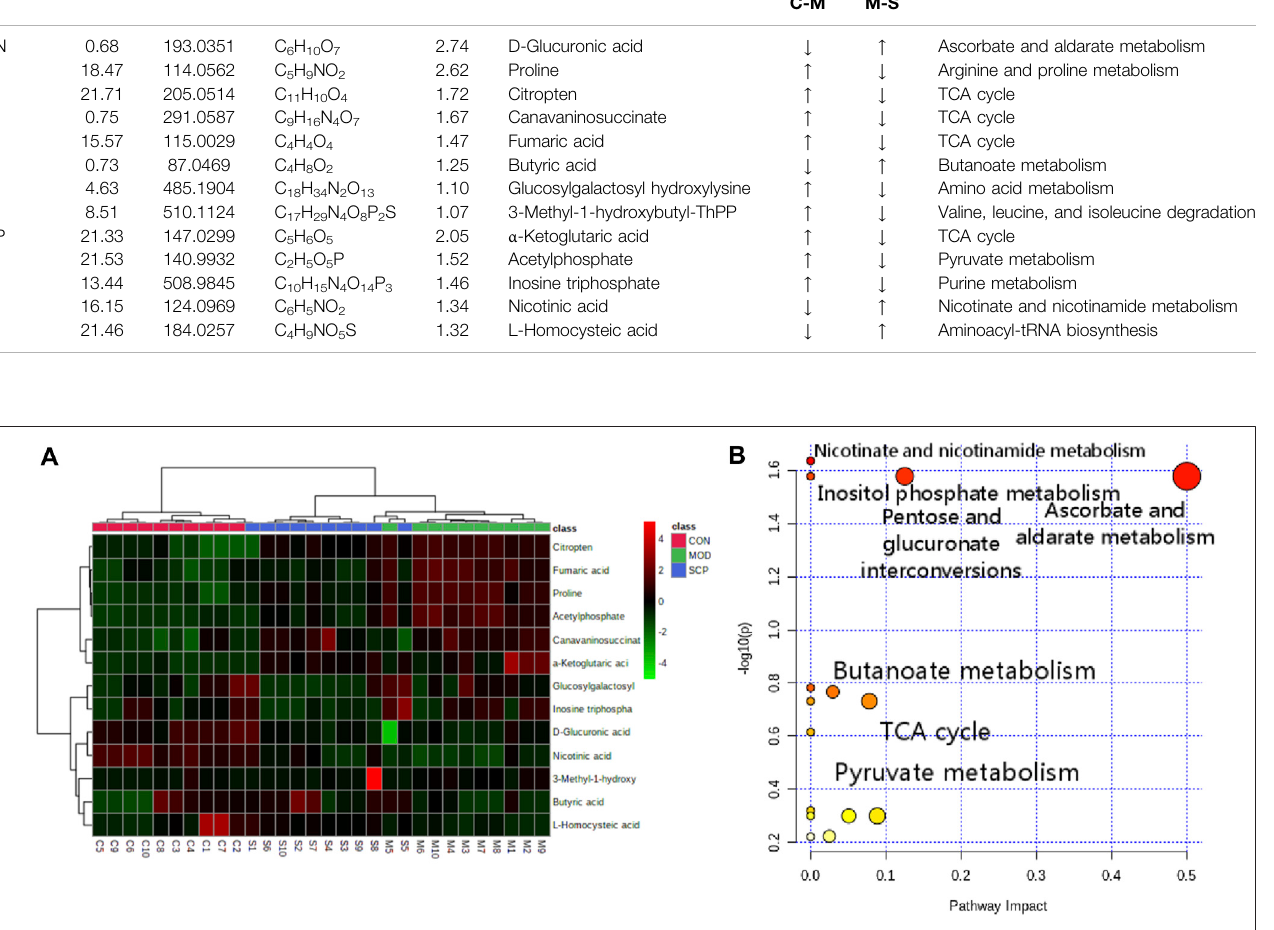
Frontiers in Pharmacology |